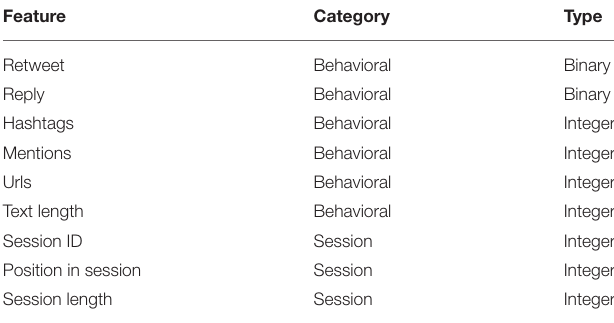
TABLE 1 | Statistics for account groups. Accounts